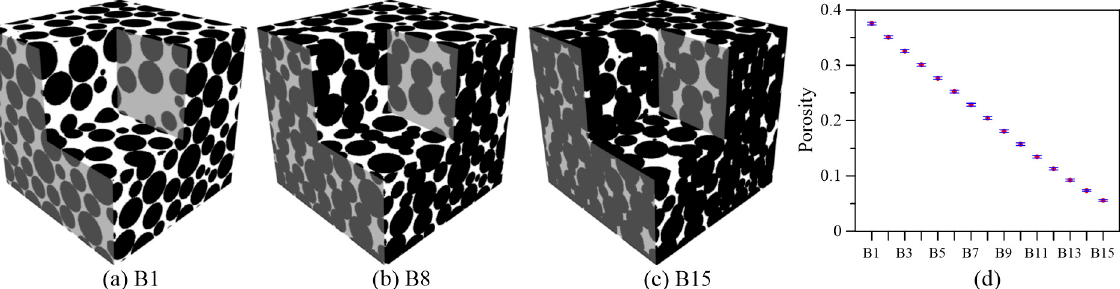
Figure 4. Digital 3D images and porosity evolution of compaction model. ( a – c ) are B1, B8, and B15 sub-models, respectively; ( d ) Porosity evolution.